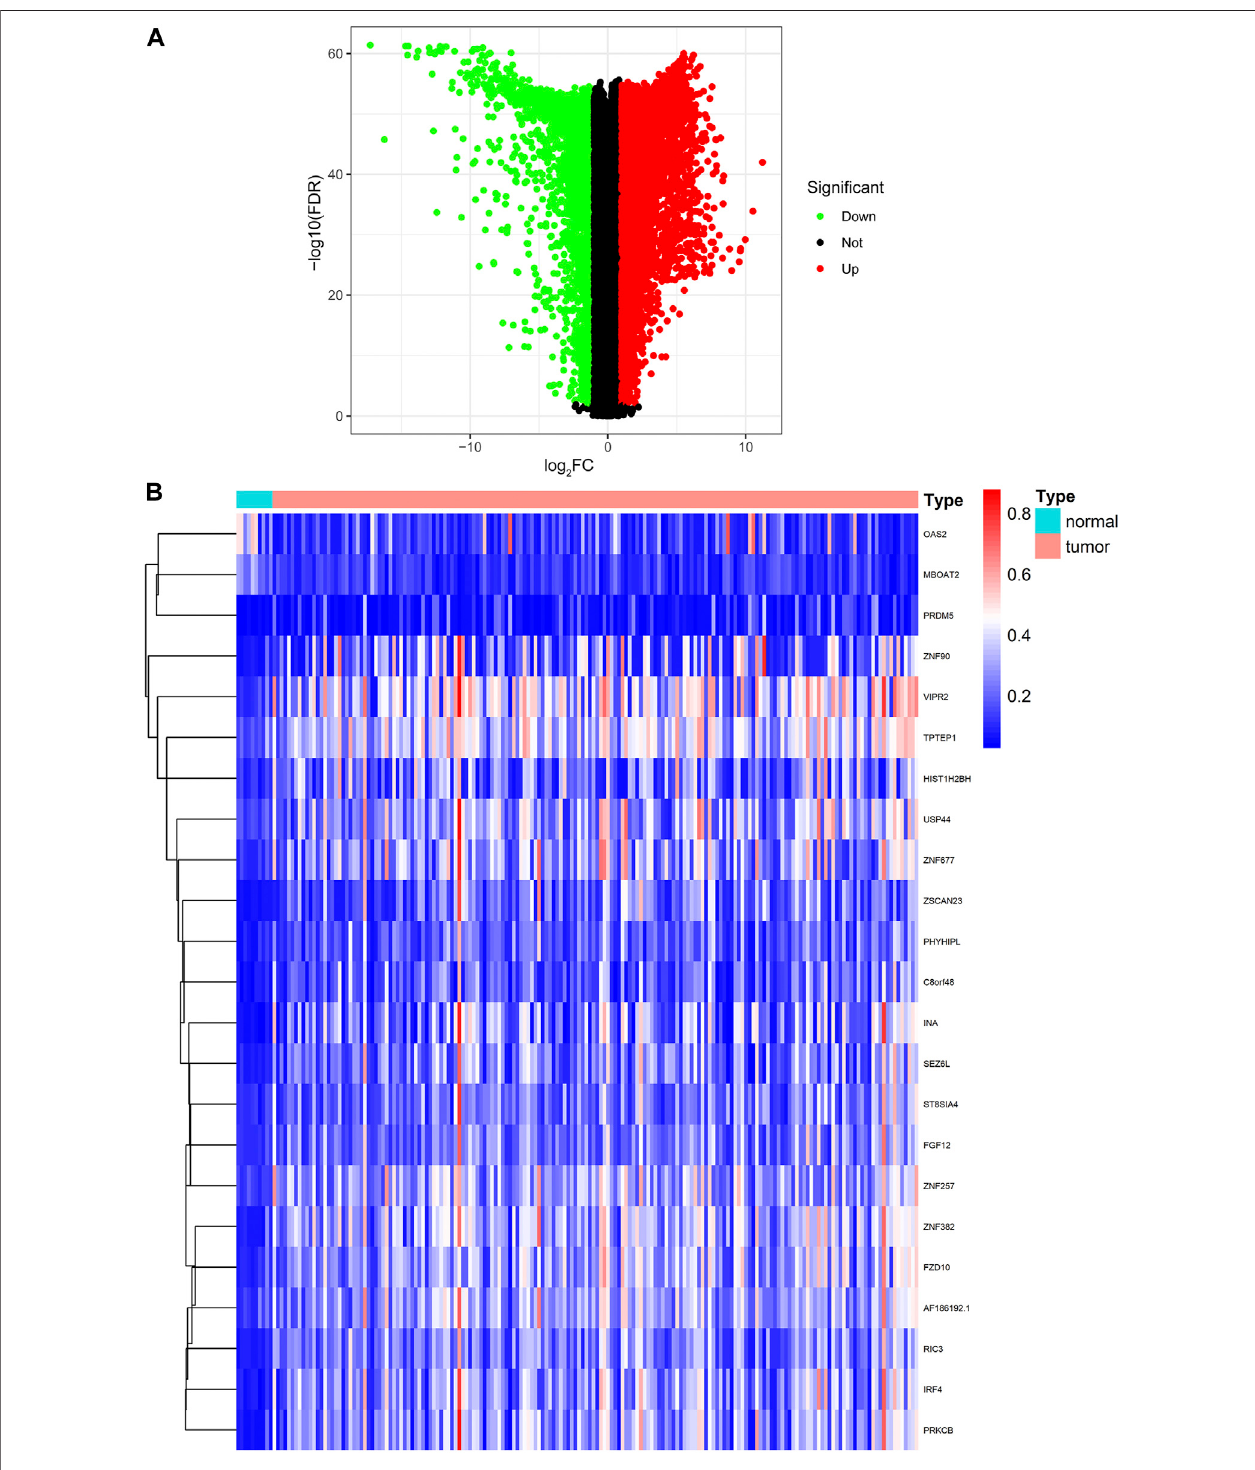
FIGURE 2 | Identi fi cation of DEGs and DNA methylation-driven genes. (A) Volcano plot of DEGs. (B) Heatmap of the methylation levels of 23 candidate DNA methylation-driven genes in PC ( n (cid:1) 185) and normal pancreatic tissues ( n (cid:1) 10). DEGs, differentially expressed genes; PC, pancreatic cancer.